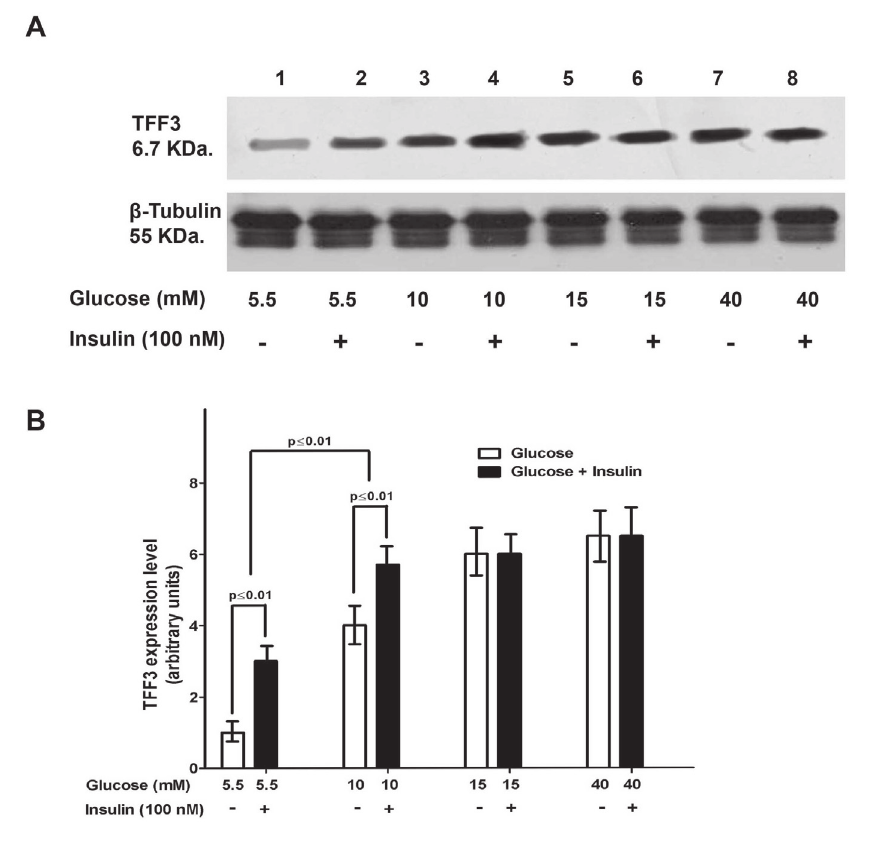
FIGURE 4. Inmunoblot for TFF3 and Tubulin. HT-29 cells were grown in 6-well plates at 50% con fl uence and serum-starved for 24 h. Cells were treated with different glucose concentrations (5.5 mM, 10 mM, 15 mM, and 40 mM), with or without insulin (100 nM) for 6 h. (A) Whole cell lysate (20 μ g) from HT-29 cell monolayers which express TFF3, were run on non-denaturing 15% SDS-PAGE and electrotransferred to a nitrocellulose fi lter. Then, proteins in the membrane were denatured, renatured and blocked overnight at 4°C. TFF3 was detected using anti-TFF3 as primary antibody (upper panel). Then, membranes were stripped and reprobed using standard Immunoblotting to determine Tubulin on the lysate (lower panel). The relative amount of product was quanti fi ed by densitometric analysis of DNA bands (B). Results are mean ± SEM of three independent